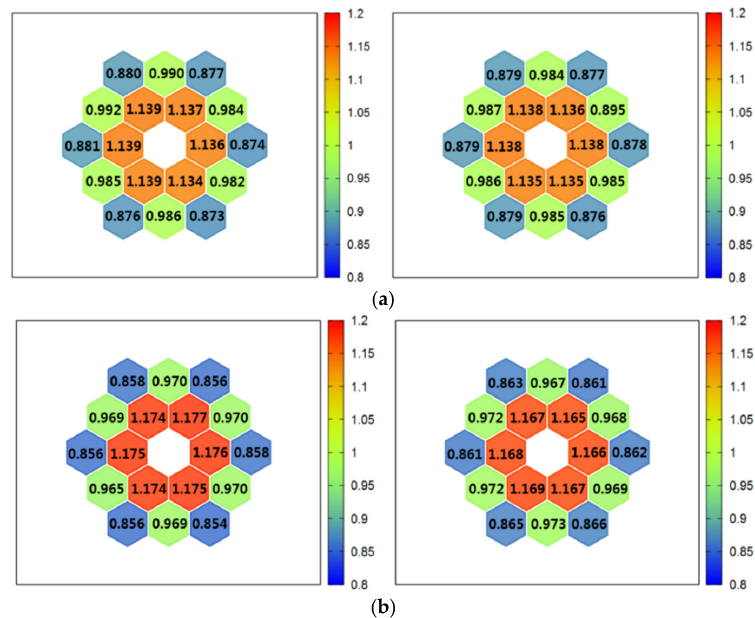
Figure 11. Normalized radial power distributions of the MMR core. ( a ) Beginning of life (BOL) and middle of life 1 ( MOL1) of the first ‐ half cycle core; ( b ) middle of life 2 ( MOL2) and end of life (EOL) of the second ‐ half cycle core.